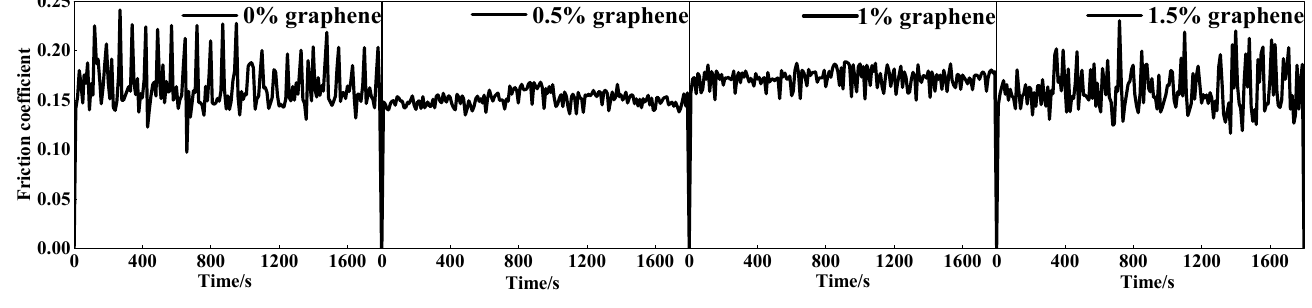
Figure 11. Friction coefficient curve of the cladding layer.